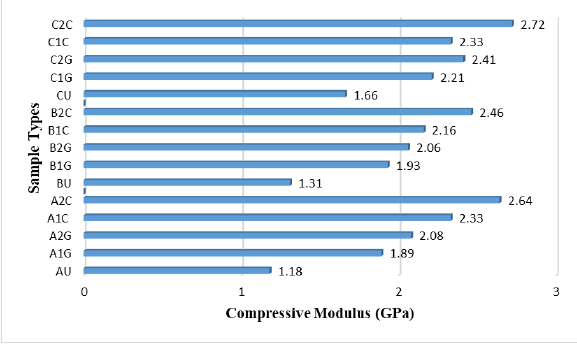
Figure 9: Bar-chart of compressive modulus of group A, B and C confined